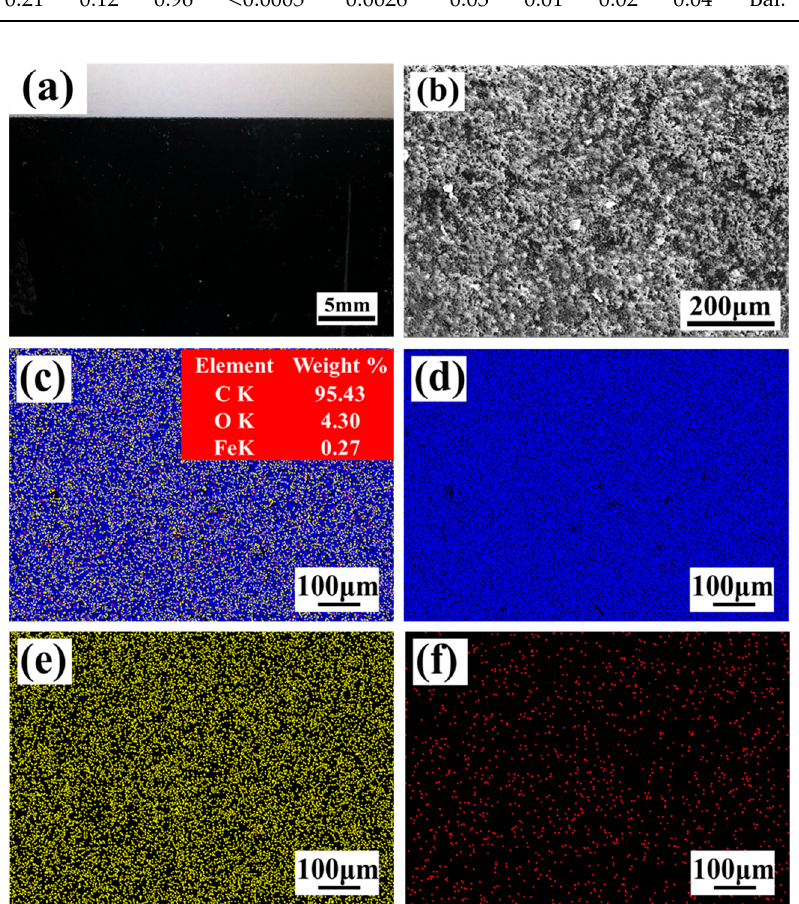
Figure 1. Morphology and EDS mapping of the black paint layer on the surface of Q345 steel. ( a ) OM; ( b ) SEM. ( c ) Overlay elements and percentage content; ( d ) C element; ( e ) O element; ( f ) Fe element.